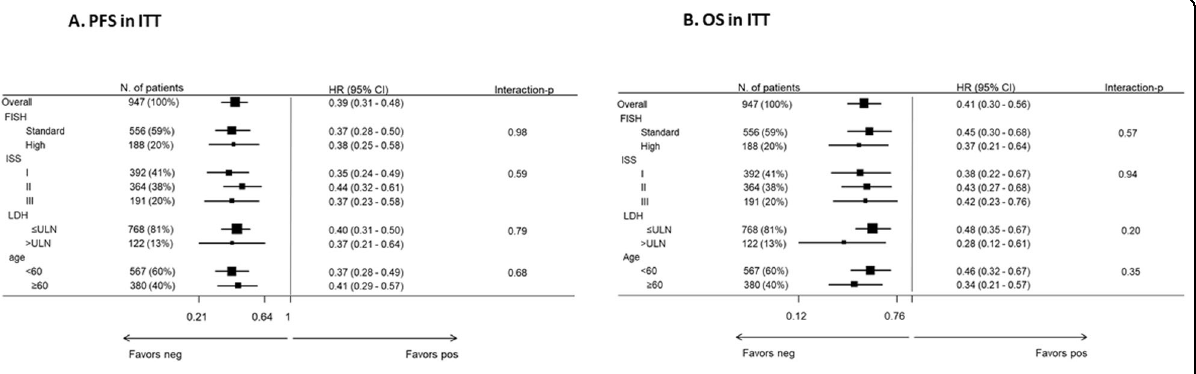
Fig. 4 FISH, fl uorescence in situ hybridization; ISS, International Staging System; LDH, lactate dehydrogenase; ULN, upper limit of normal; PFS, progression-free survival; OS, overall survival; ITT, intention-to-treat. A Subgroup analysis of progression-free survival in the intention-to- treat population. B Subgroup analysis of overall survival in the intention-to-treat